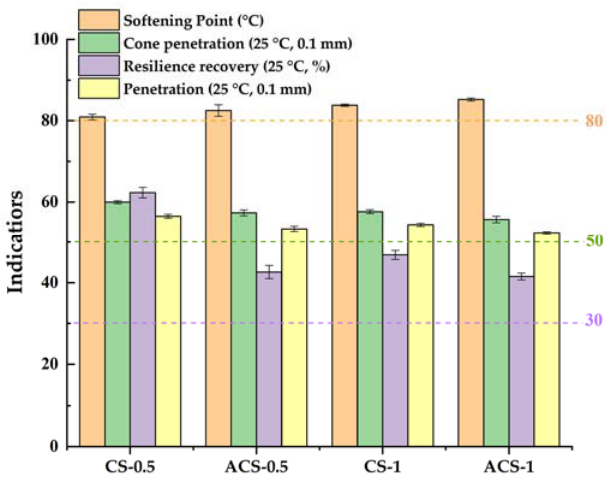
Figure 7. Conventional indicators of sealants. Table 7. Flow value of sealants.